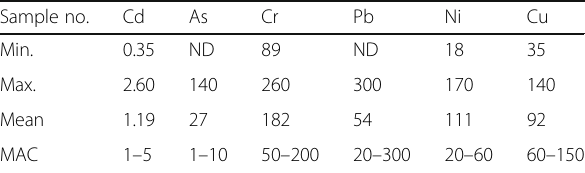
Table 2 Heavy metal content in the studied soil samples (ppm) Sample no.